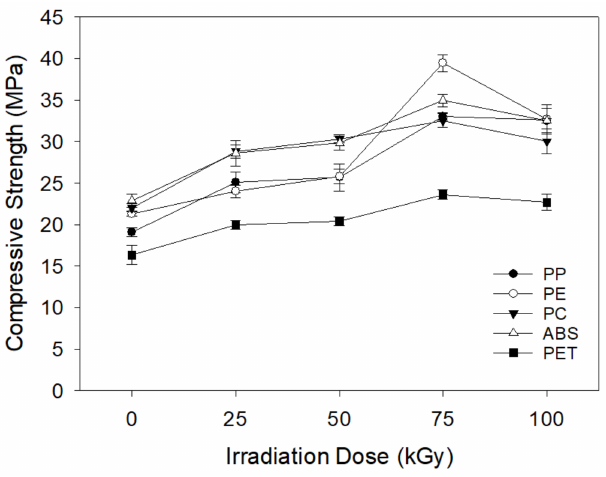
Figure 22. Compressive strength of cementitious composites according to irradiation